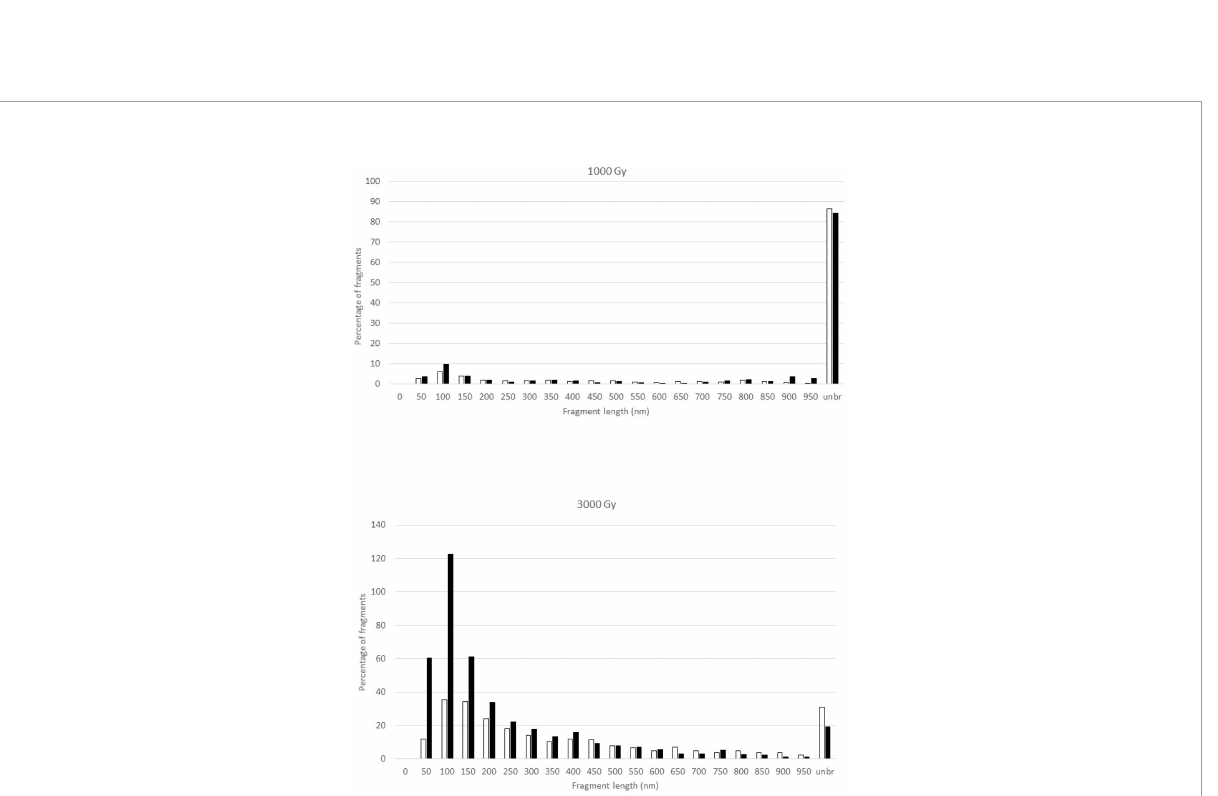
FIGURE 2 Fragment size distribution of the pUC19 plasmid DNA after exposure to 1000 Gy (upper panel) and 3000 Gy (lower panel) proton irradiation in the plateau (2-cm depth, open bar) and at the peak (9.4-cm depth, solid bar) of the 110 MeV Pristine proton bream. Where the number of fragments in each length bin is normalized to the total number of DNA molecules that include both broken DNA and intact DNA, which results in the percentage of fragments greater than 100 for the 3000 Gy irradiated DNA samples. The Y-axis, the percentage of fragments, is the number of DNA fragments measured in a speci fi c length bin, i.e., 0-50 nm, divided by the total number of DNA molecules measured for a sample, and multiplied by 100.